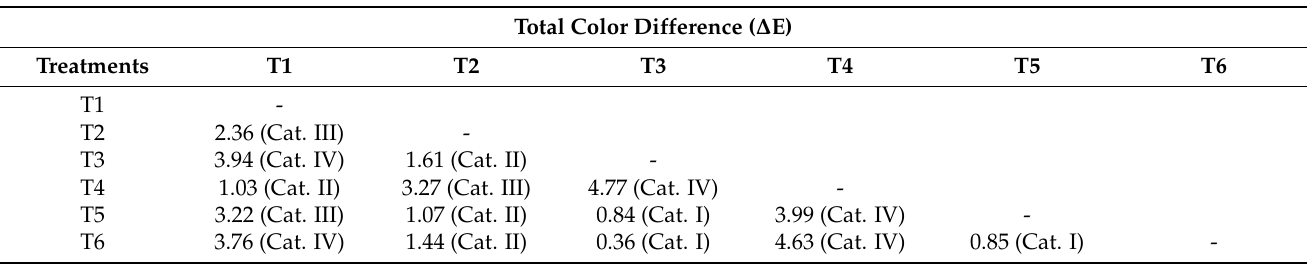
Table 4. Total color difference ( ∆ E) between chicken breasts cooked with different combinations of temperatures and time durations. Total Color Difference ( ∆